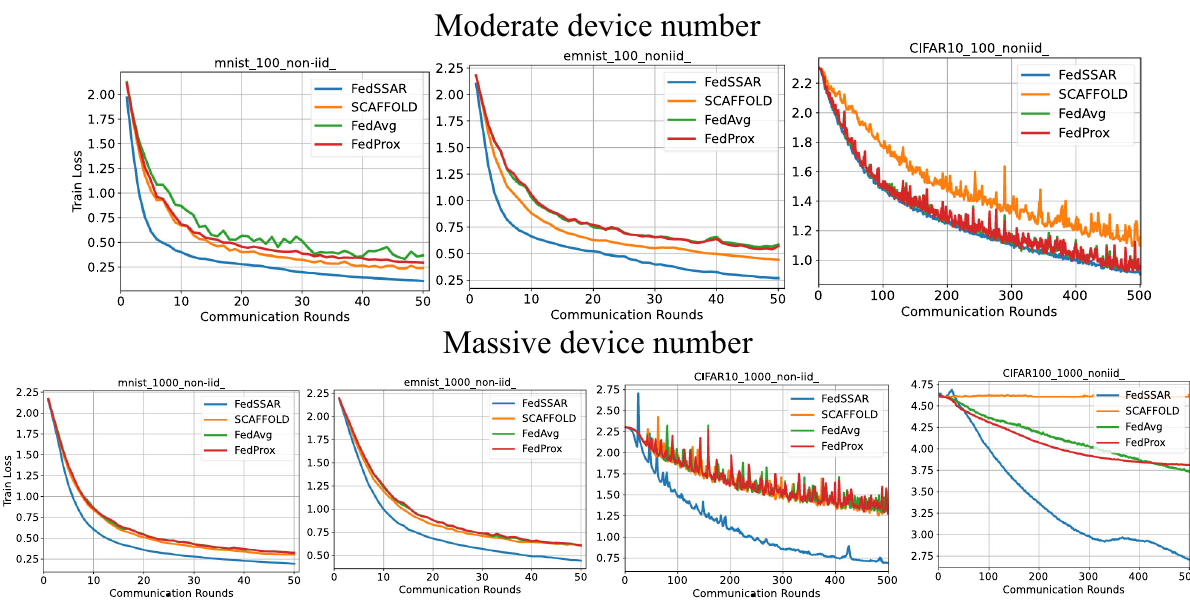
Fig. 12 Training loss of FedSSAR and other methods, using decreasing η t and weight decay to achieve the best training performance during the last 50 training rounds for MNIST and EMNIST-L, 500 for Cifar-10 and Cifar-100 (non-IID